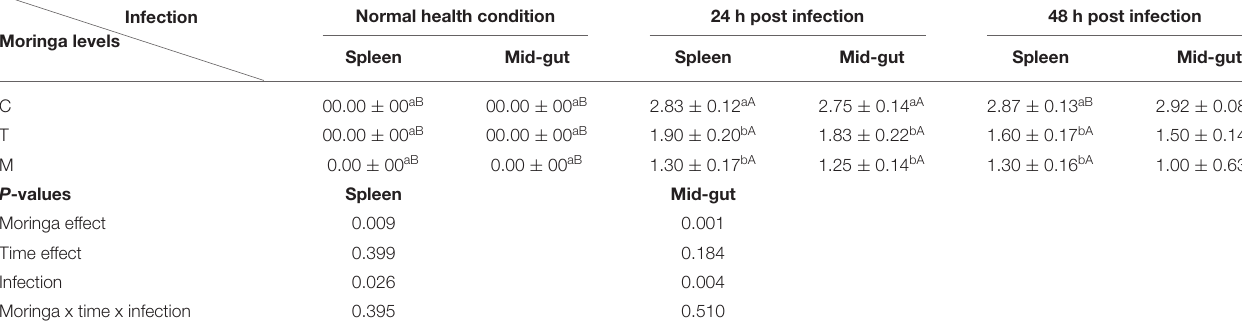
TABLE 8 | Goblet cells count (cell count/mm 2 ) under normal health condition and following A. hyrdophila infection.